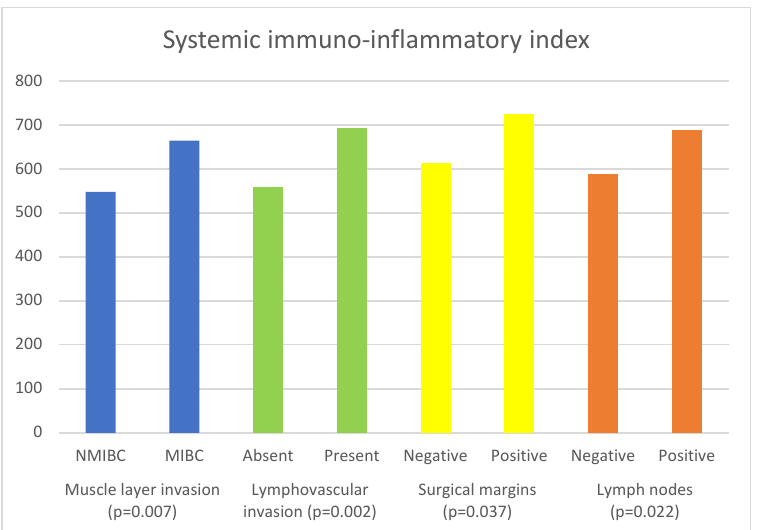
Figure 3. Significant associations of systemic immuno-inflammatory index with histopathological characteristics of bladder cancer. A graphical presentation of the significant associations of SIRI with the histopatho- logical features of BC is presented in Figure 4.